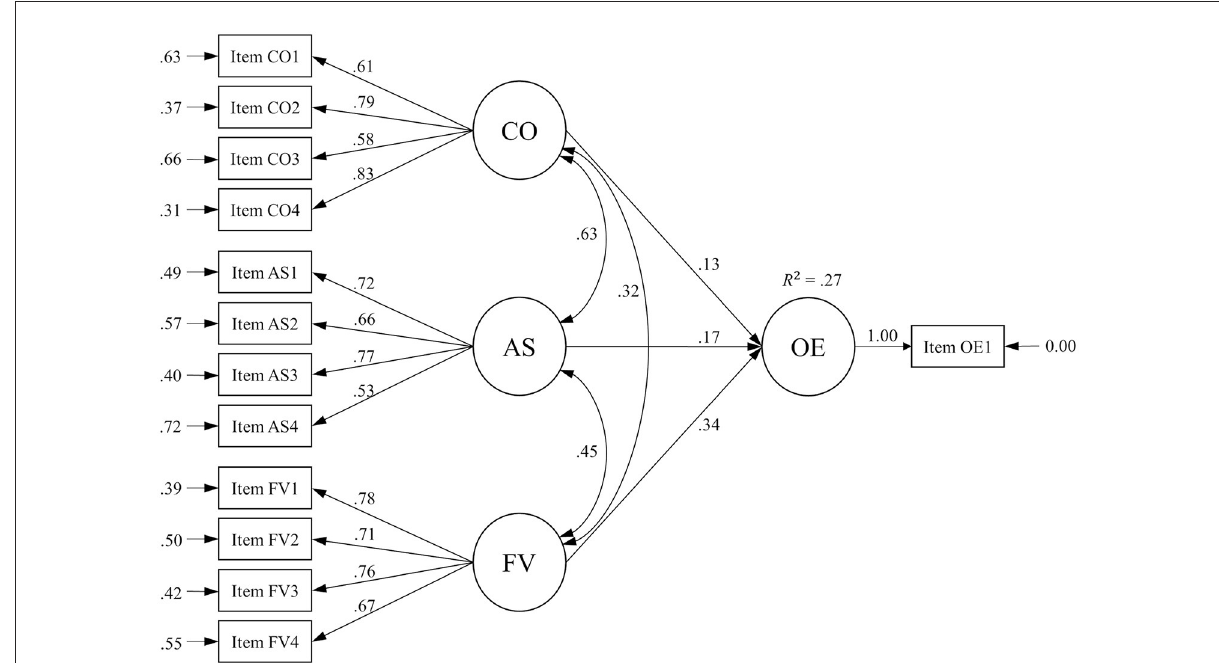
FIGURE1 Proposed structural equation model. CO, controllability; AS, absence of strain; FV, face validity; OE, overall evaluation; standardized loading, structural and effect size estimates obtained from the complete sample ( N = 1,876); the variances of all exogenous variables were set to 1 for model identification; all estimates are significant with p <